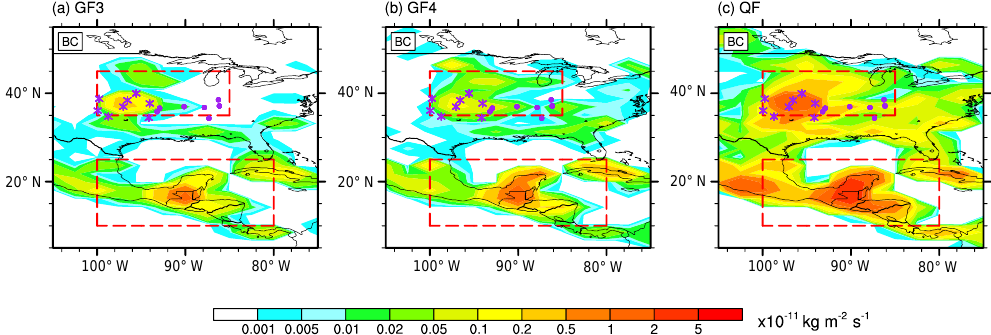
Figure 2. Spatial distributions of monthly mean BC emissions from three emission inventories in April 2009. IMPROVE data sites are shown as asterisks for sites near the source region and as dots for sites in the region downwind of the fire